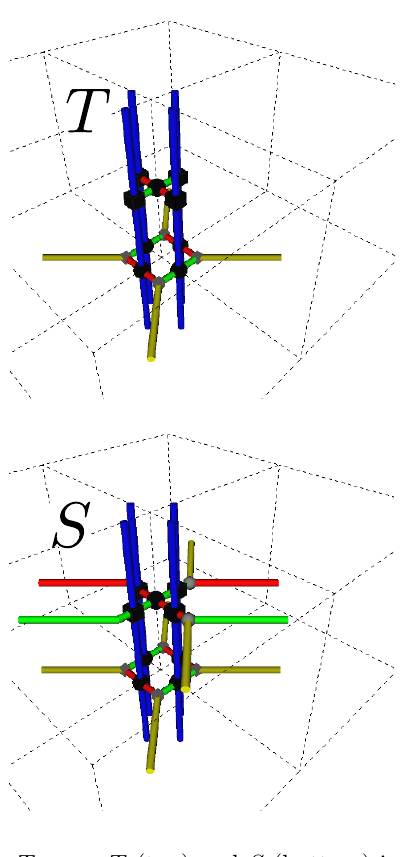
Figure 4 . Tensors T (top) and S (bottom) in eq. (2.17).